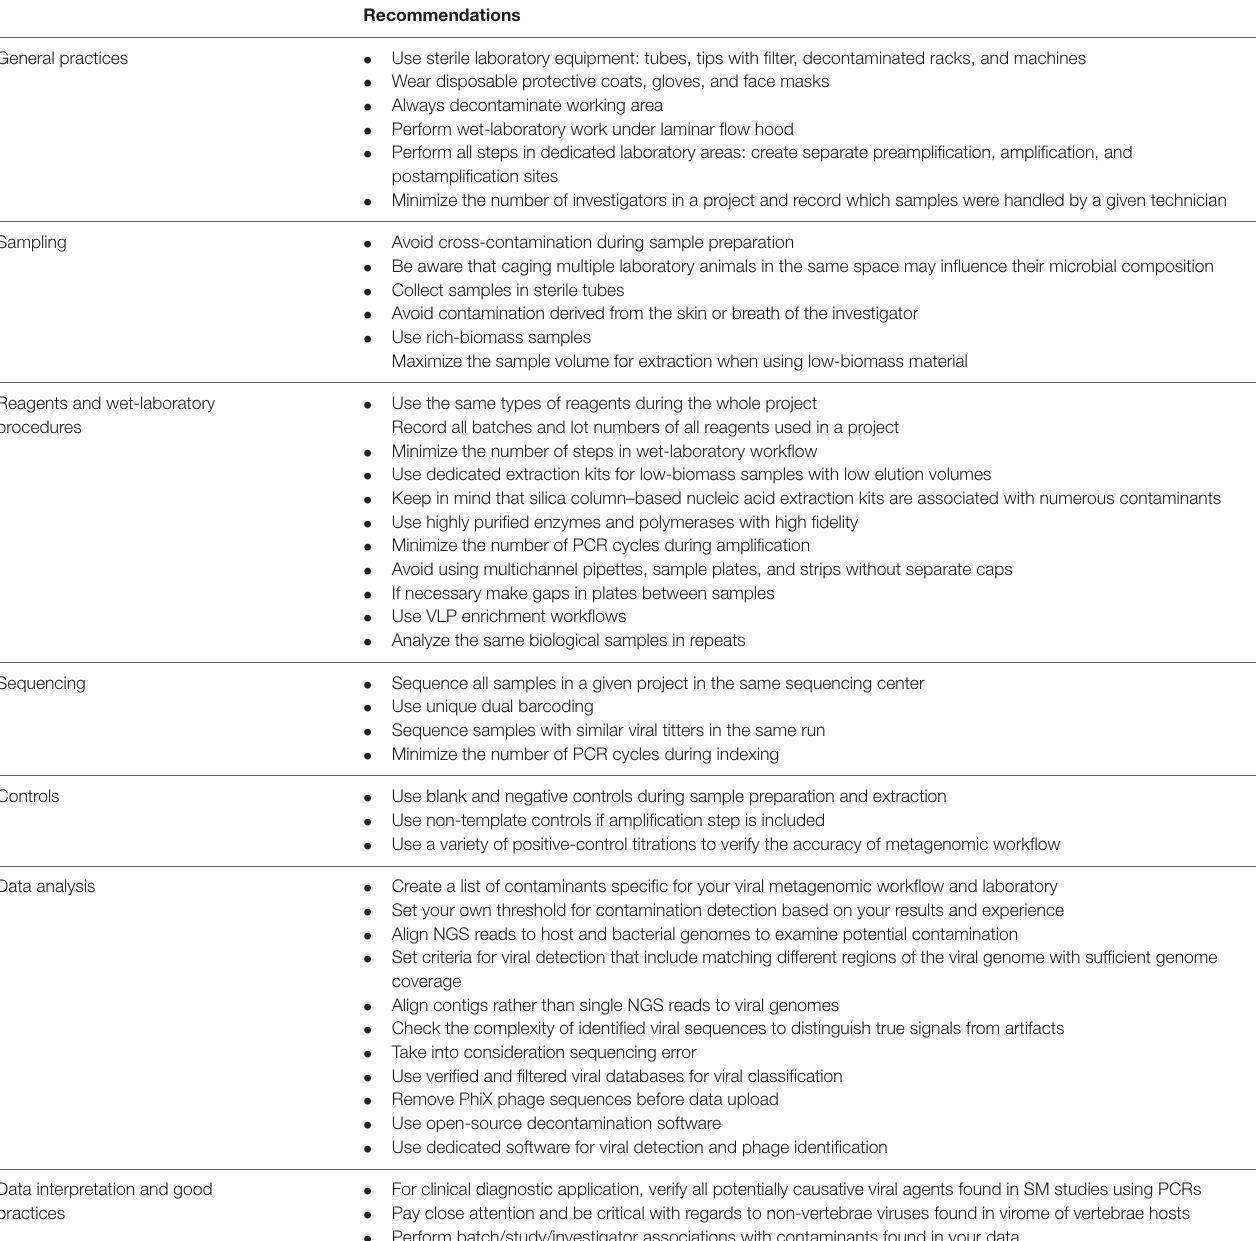
TABLE 1 | Recommendation for reducing contamination in viral metagenomic